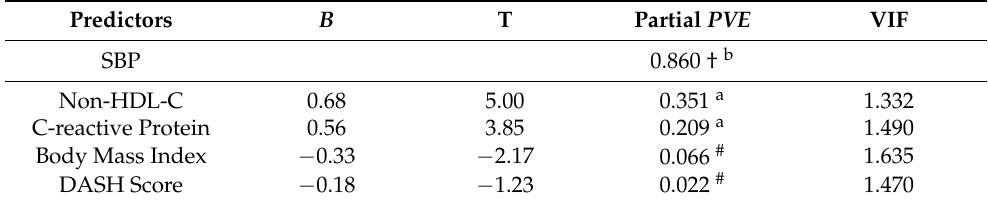
Table 5. The Proportion of Variance Explained in the Multivariate Linear Regression Models for Resting Blood